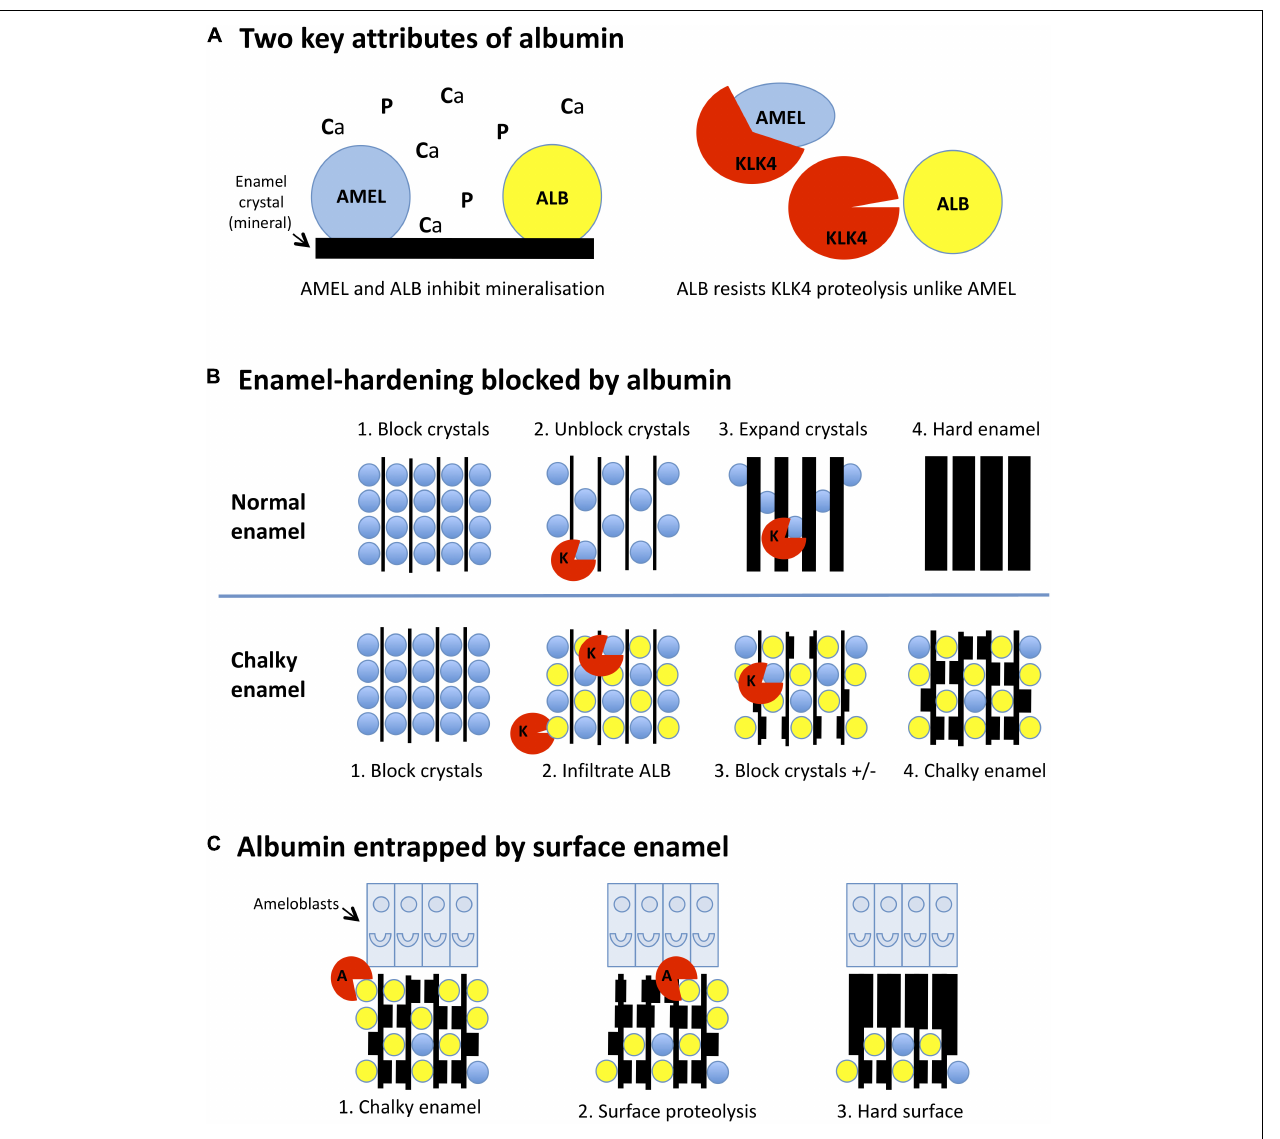
FIGURE 2 | Mineralisation-poisoning model for chalky opacities. Translational depiction of the MP working model described in the text. Colour codings and abbreviations are: amelogenin, blue /AMEL; albumin, yellow /ALB; kallikrein-4, red /KLK4 or K; albuminase, red /A. (A) Albumin has two key attributes that lead it to disrupt enamel hardening and survive in chalky enamel. ( Left panel ) Like amelogenin, albumin binds tightly to enamel crystals, blocking access of calcium and phosphate ions ( Ca, P ) to the growth surface. Consequently, albumin mimics the crystal-blocking properties of amelogenin. ( Right panel ) In contrast to amelogenin, albumin is resistant to kallikrein-4, the pivotal protease involved in enamel hardening. Albumin can therefore remain adhered to enamel crystals while amelogenin is being degraded. (B) Albumin blocks the hardening of enamel. ( Upper panels, 1-4 ): ( 1 ) During the initial (secretory) stage of enamel formation, immature enamel crystals are temporarily blocked from further growth by adherent amelogenin. ( 2 ) Kallikrein-4 embarks on what will become the complete removal of amelogenin. ( 3 ) Ensuing ingress of calcium and phosphate enables crystals to expand, eventually producing hard enamel ( 4 ). In chalky enamel ( lower panels, 1-4 ), infiltrated albumin occupies crystal-binding sites left vacant by amelogenin ( 1,2 ) and uniquely resists degradation by kallikrein-4. ( 3 ) Crystal expansion is blocked at albumin-bound sites, but proceeds elsewhere following further removal of amelogenin. ( 4 ) Extension of this process leads to porous chalky enamel containing abundant albumin plus traces of residual amelogenin. (C) Subsurface albumin becomes entrapped by hardening of surface enamel. ( 1 ) Late in the enamel-hardening process, certain albumin-degrading proteases are released by ameloblasts or neighbouring cells. ( 2 ) Degradation of superficial albumin and amelogenin enables crystal growth at the enamel surface. ( 3 ) Extension of this process produces an impermeable layer of surface enamel that entraps albumin and other subsurface proteins, culminating macroscopically as an intact chalky opacity.